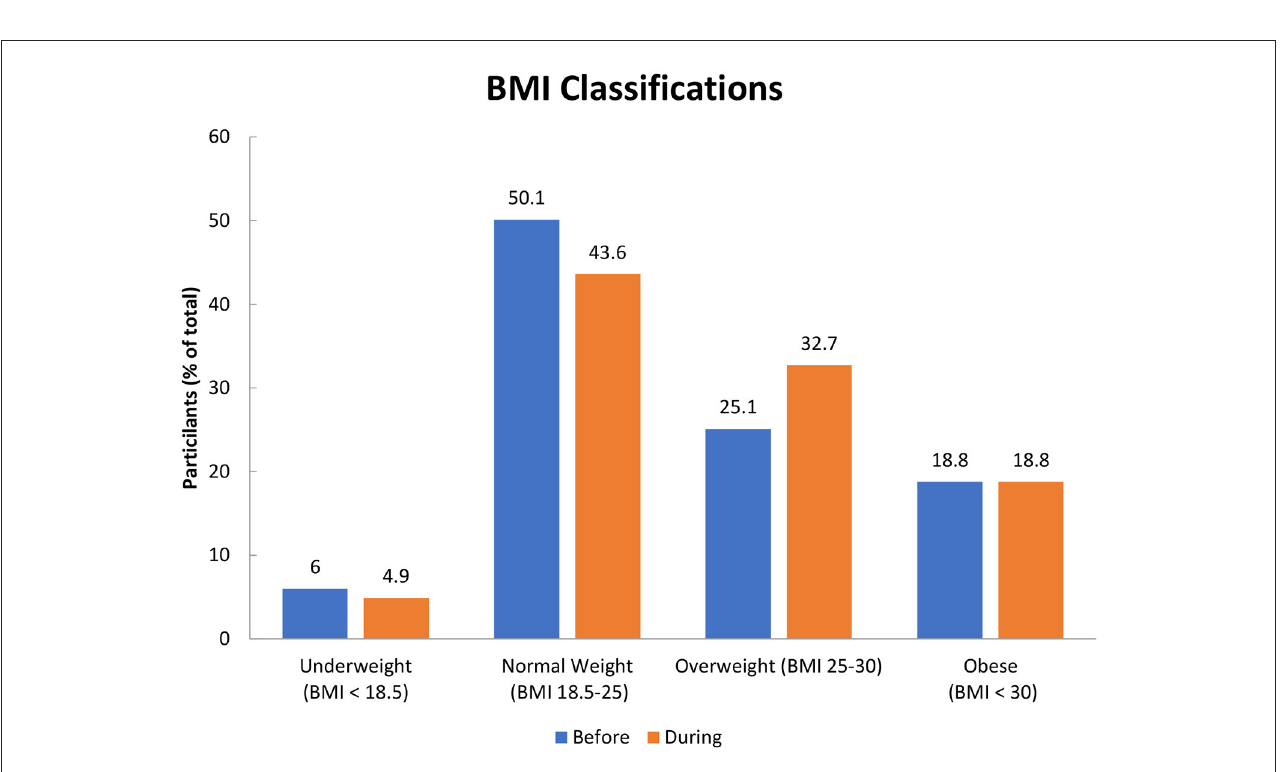
FIGURE1 BMI classification before and during COVID-19